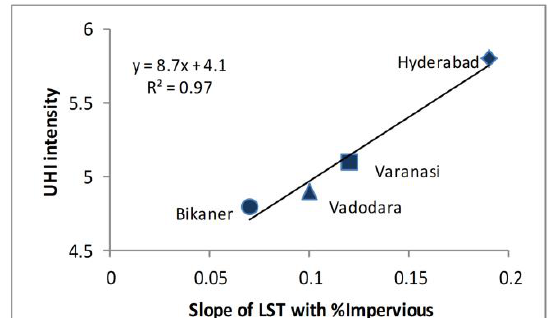
Figure 5. Plot of UHI intensity with the slope of linear relation of night LST with % Impervious UHI intensity was found higher in Hyderabad because the surrounded hills reduces wind velocity and heat gets